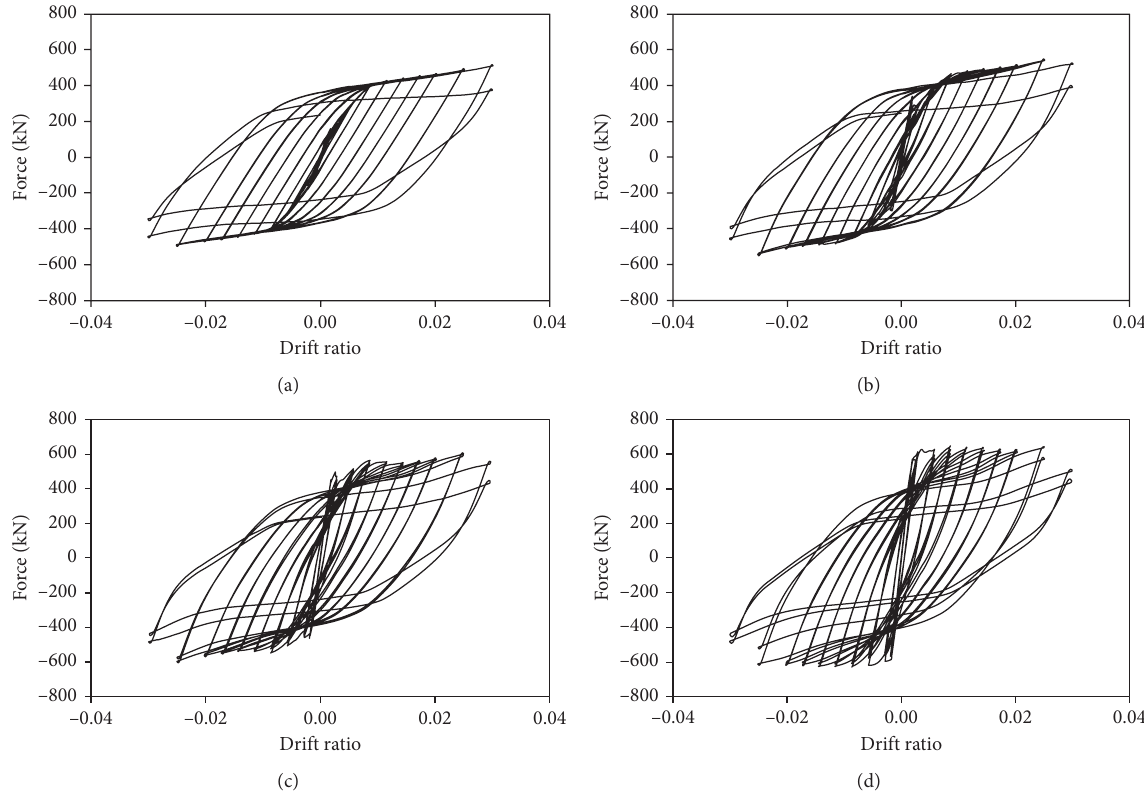
Figure 14: Hysteresis curves of beam-only-connected V-CSPSWs for different plate thicknesses. (a) t � 0.5 mm. (b) t � 1.0mm. (c) t � 1.5 mm. (d) t �